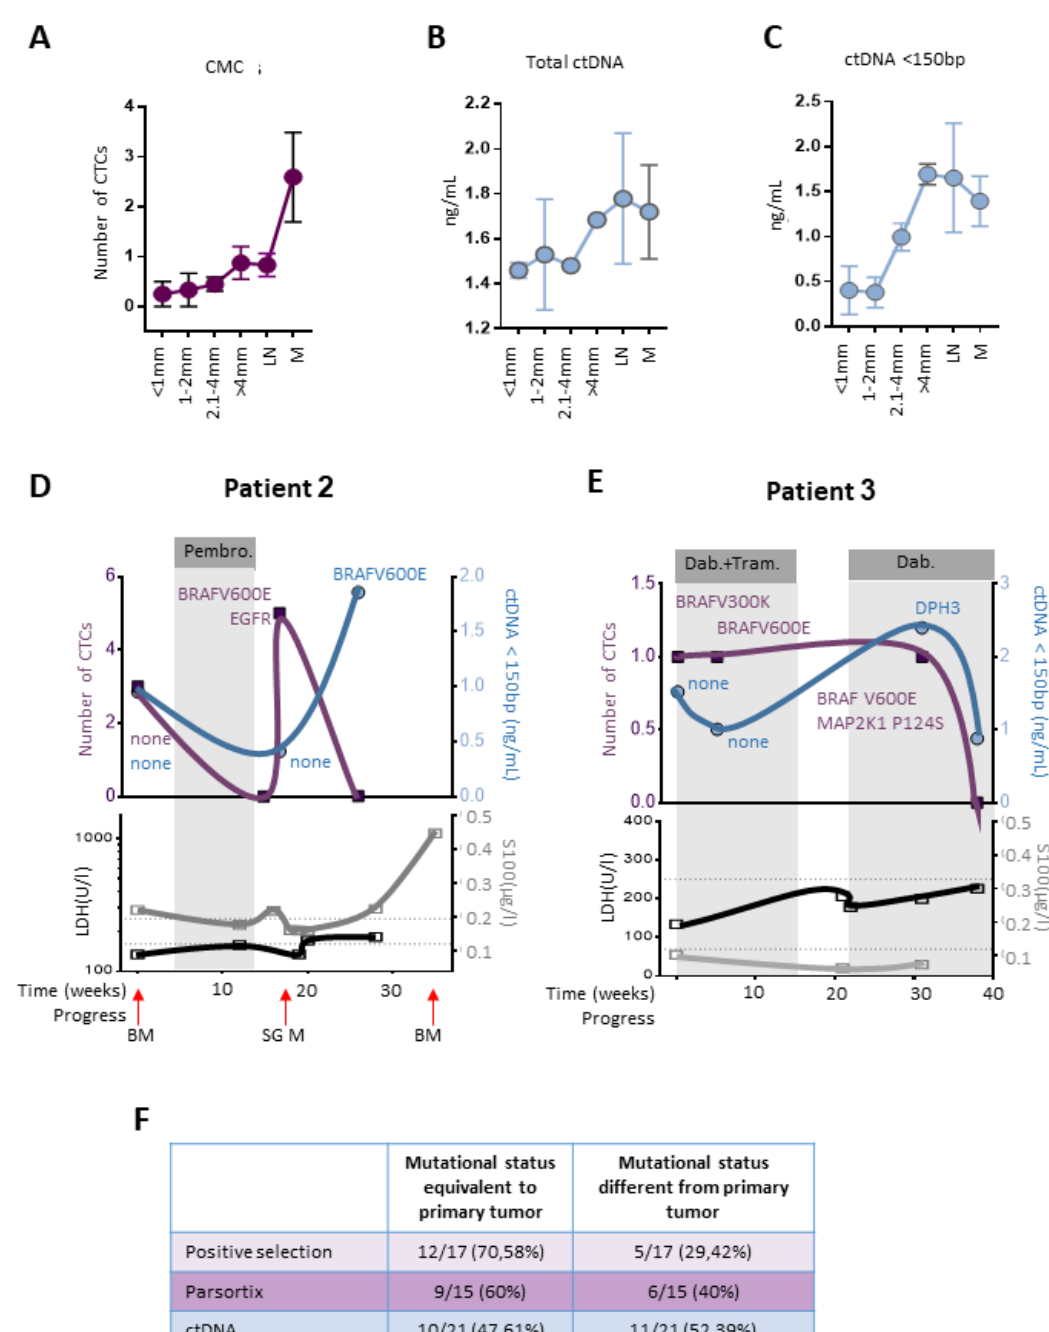
Figure 4. Comparison of CTC and ctDNA detection ( A – C ) CTCs, total ctDNA and ctDNA < 150 bp detected in patients with primary tumors (Breslow depth), lymph node metastasis (LN) and distant metastasis (M) ( D , E ) Time course of CTC detection, ctDNA, mutations detected in both CTCs and ctDNA, LDH and S100 serum levels in patients 2 and 3. ( F ) Mutational status for each detection method compared to the primary melanoma.